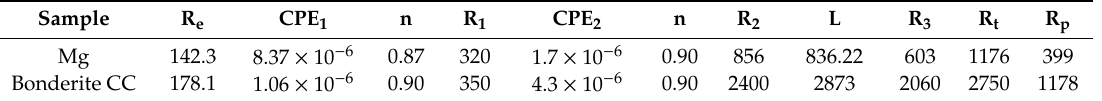
Table 5. Fitted parameters of the EIS data for the Mg and Bonderite CC specimens after 30 min of immersion in 0.5 % wt. NaCl. (R given in Ω cm 2 ; CPE given in S s − n cm − 2 ; L given in Ω s cm 2 ).